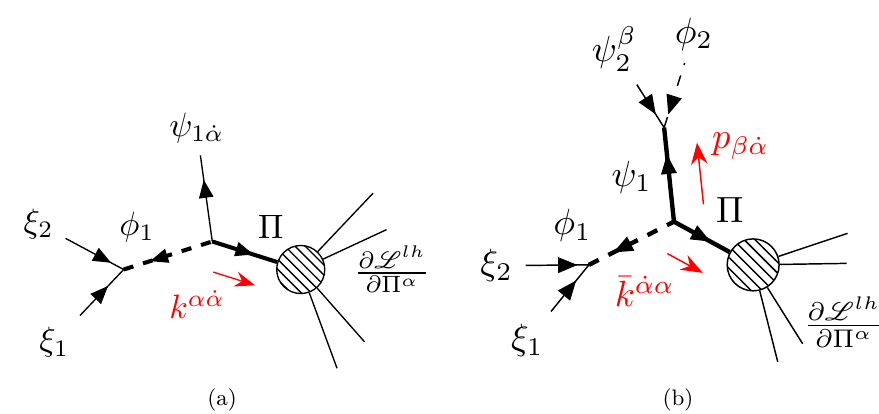
Figure 4. (a) The diagram shows an example opening of an operator containing at least one derivative. The derivative can be understood as arising from the leading-order term in the expansion of the arrow-preserving fermion propagator, emphasised in the diagram. As shown, the fields ξ i and ψ 1 are external and therefore light, but in general they could themselves be heavy